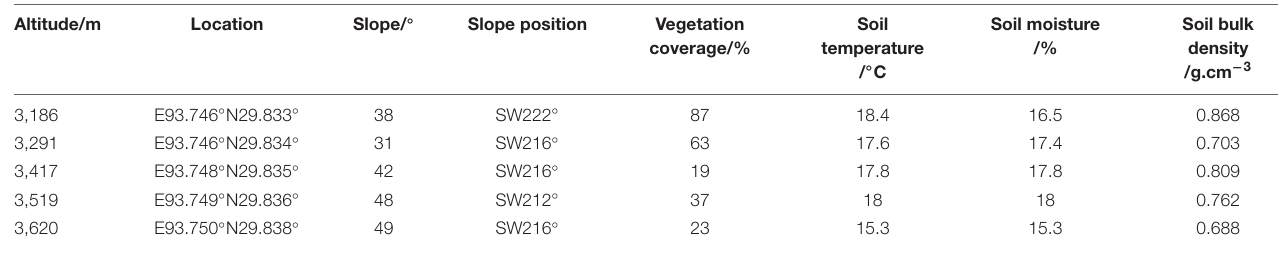
TABLE 1 | Basic information of sample sites.